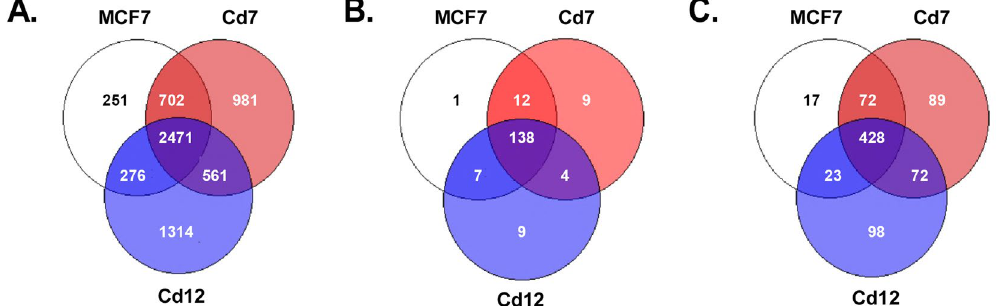
Figure 5. Prolonged cadmium exposure alters the regulation of estrogen-responsive genes. The Venn diagrams represent the ( A ) total, ( B ) ERE (estrogen response element), and ( C ) estrogen-responsive genes identified by RNA-seq that were altered in the same or different directions (up- or downregulated) in MCF7, Cd7, and Cd12 cells after antiestrogen